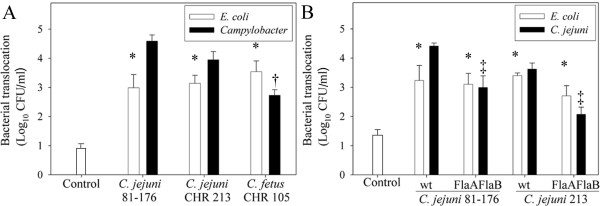
Translocation of E. coli does not correspond with Campylobacter invasiveness. (A) Translocation of E. coli HB101 (white bars) and Campylobacter (black bars) in T84 monolayers infected with highly (strain 81–176), moderately (CHR213), and modestly-invasive (CHR105) Campylobacter strains, 4 h post-infection. (B) Translocation of E. coli HB101 (white bars) and Campylobacter (black bars) in T84 monolayers treated with wild-type C. jejuni 81–176 and CHR213, and corresponding invasion-defective FlaAFlaB mutants Data are means ± SEM (n = 3). *P < 0.05 compared to control monolayers. †P < 0.05 compared to C. jejuni 81–176 and C. jejuni CHR213. ‡ P < 0.05 compared corresponding wild-type C. jejuni-treated monolayers.